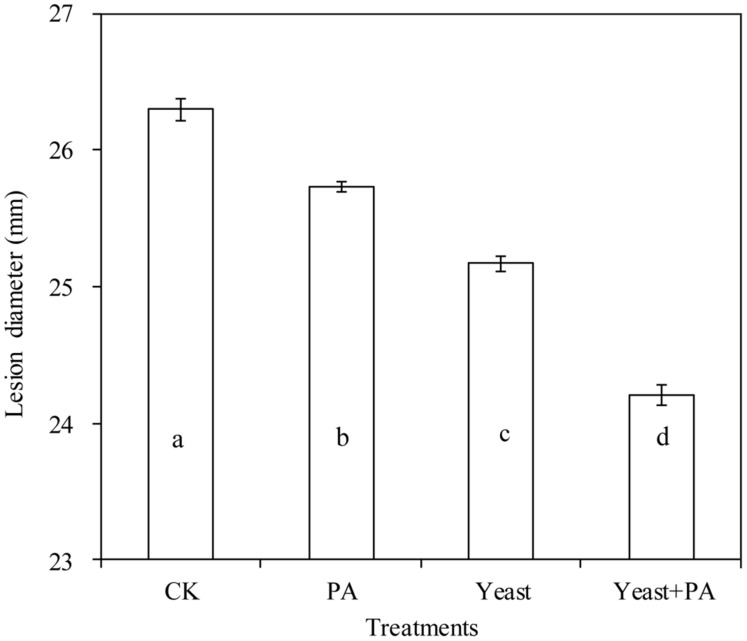
Effects of R. mucilaginosa in combination with PA on mycelial growth of Penicillium expansum. Treatments are as follows: CK = sterile distilled water, PA = 4 μmol/mL PA, yeast = R. mucilaginosa (1 × 108 CFU/mL), yeast + PA = R. mucilaginosa (1 × 108 CFU/mL) + 4 μmol/mL PA. Each value is the mean of three experiments. Bars represent standard deviations. Different letters indicate significant differences (P < 0.05) according to the Duncan’s multiple range test.